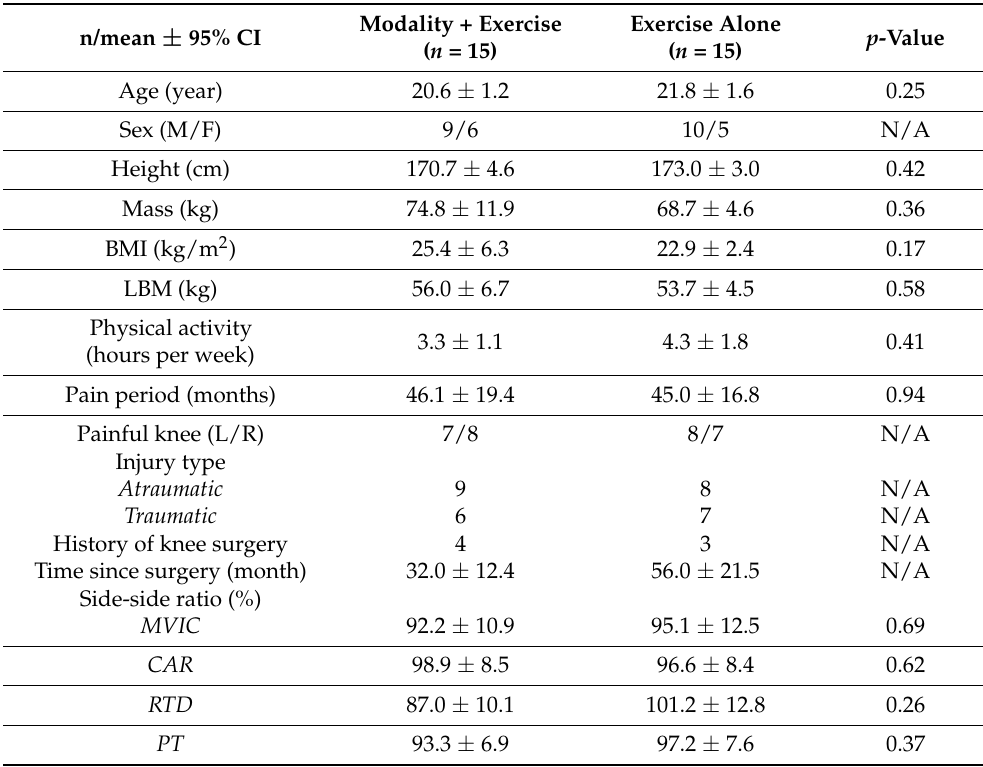
Table 1. Descriptive statistics of the